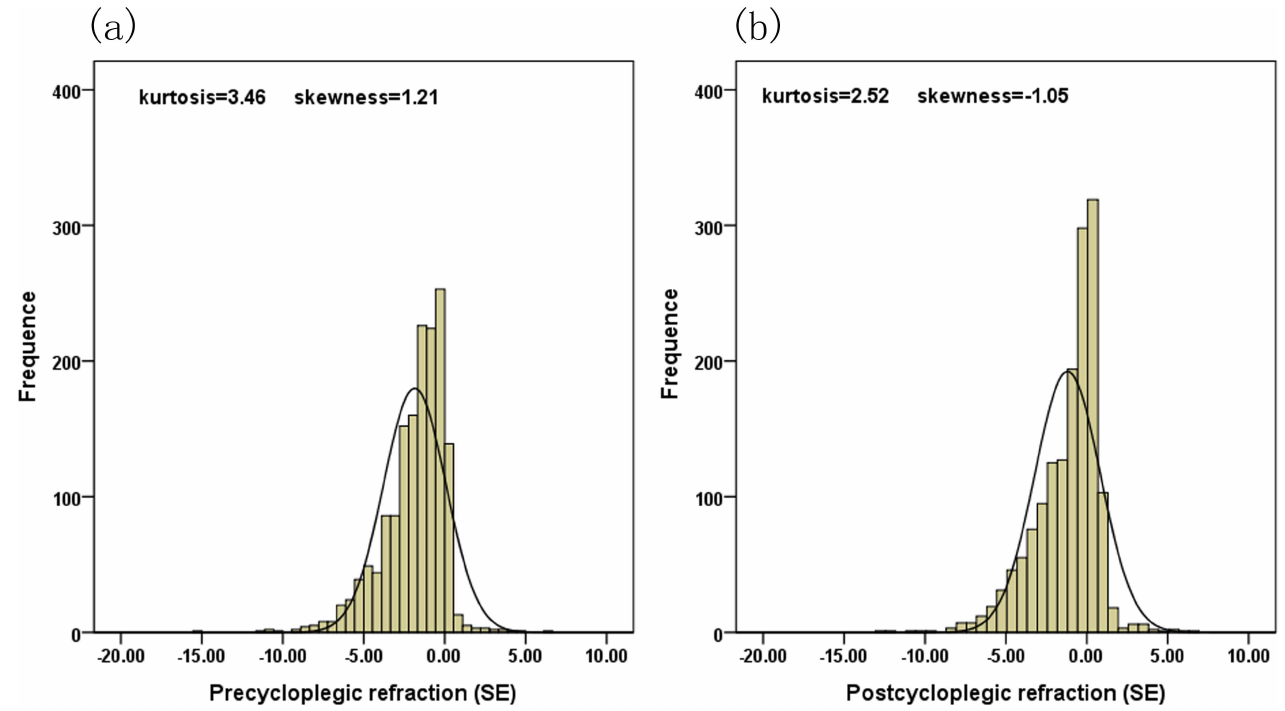
Fig 1. Distributions of spherical equivalents before and after cycloplegic